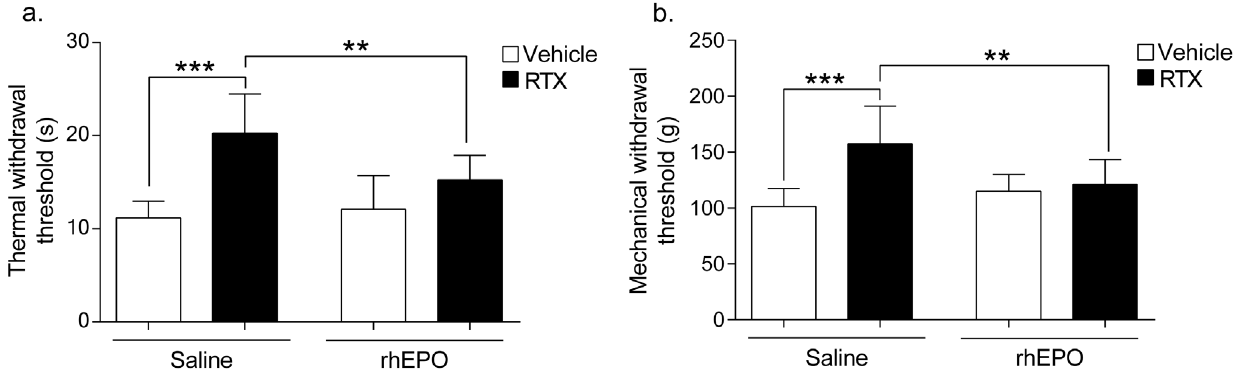
Figure 2. Effects of RTX and rhEPO on thermal and mechanical nociceptive behaviors. ( a ) Hot plate test. Withdrawal latencies to thermal stimuli (52 ˚ C). ( b ) Randall-Sellito tail pressure test. Mechanical withdrawal thresholds to nociceptive tail pressure. (n 5 10 in each group, 1-way ANOVA